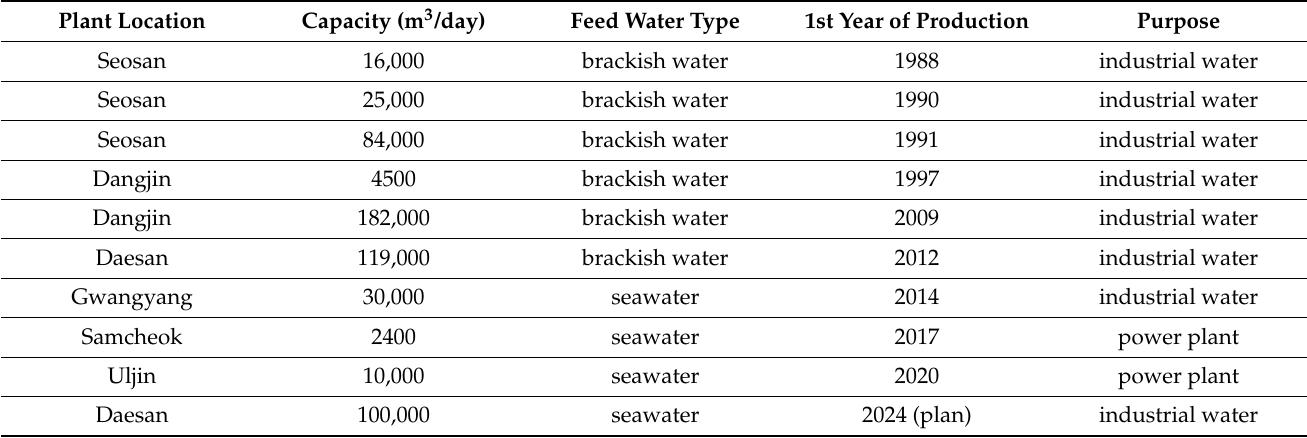
Table 1. Representative RO desalination facilities in South Korea.